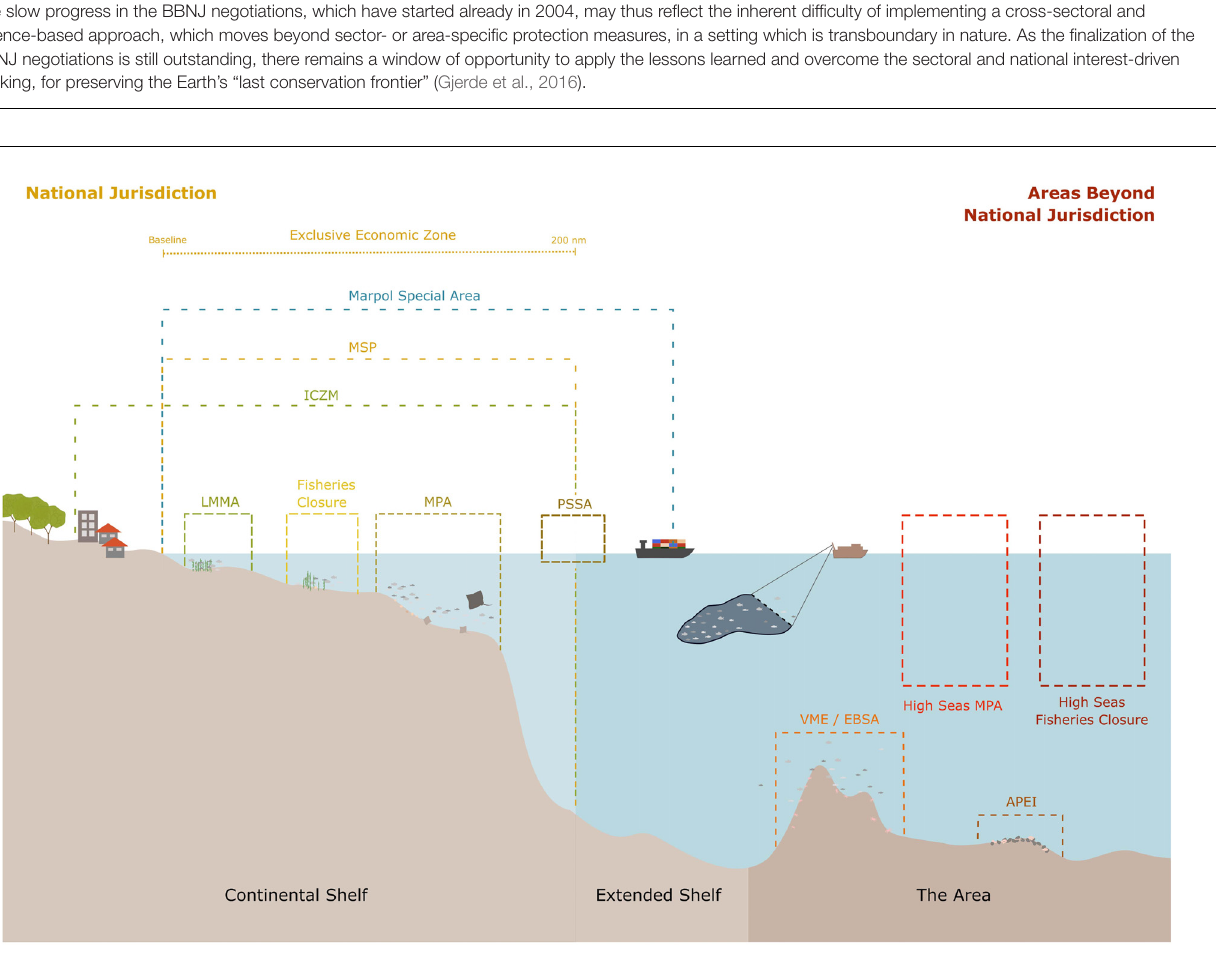
FIGURE 1 | Illustrative spatial coverage of various area-based management approaches for areas within and beyond national jurisdiction, as well as respective international management bodies (modified from UN Environment, 2018). MSP, Marine Spatial Planning; ICZM, Integrated Coastal Zone Management; LMMA, Locally Managed Marine Area; MPA, Marine Protected Areas; PSSA, Particularly Sensitive Sea Area (IMO, International Maritime Organization); VME, Vulnerable Marine Ecosystem (FAO, Food and Agriculture Organization; RFMOs, Regional Fisheries Management Organisations); EBSA, Ecologically or Biologically Significant Area (CBD, United Nations Convention on Biological Diversity); APEI, Areas of Particular Environmental Interest (ISA, International Seabed Authority).